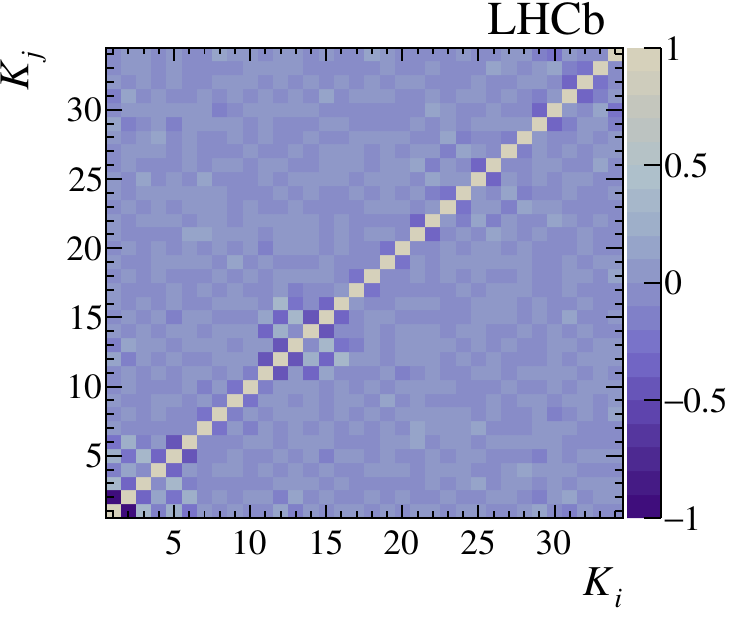
Figure 4 . Correlation coe(cid:14)cients between observables for the combined Run 1 and Run 2 data. The correlations are estimated using bootstrapped